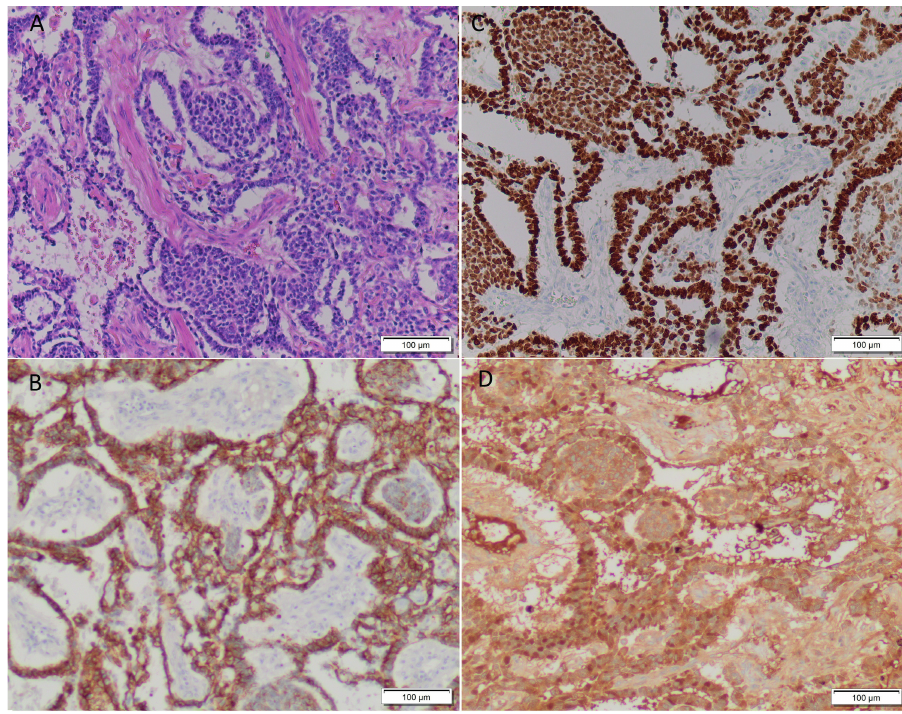
Figure 2 - The typical perivascular pattern with the characteristic Schiller-Duval bodies was predominantly observed in the conserved areas (A, Hematoxylin and Eosin stain at x10 magnifi cation). Immunohistochemistry showed strong and generalized expression of pancytokeratin (B, at x10 magnifi cation), SALL4 (C, at x10 magnifi cation) and AFP (D, at x10 magnifi cation). CDX2 was focally expressed (<10% of the neoplasm), while OCT4, CD10, CD30, FAP or CD117 were not expressed, Ki67 index was